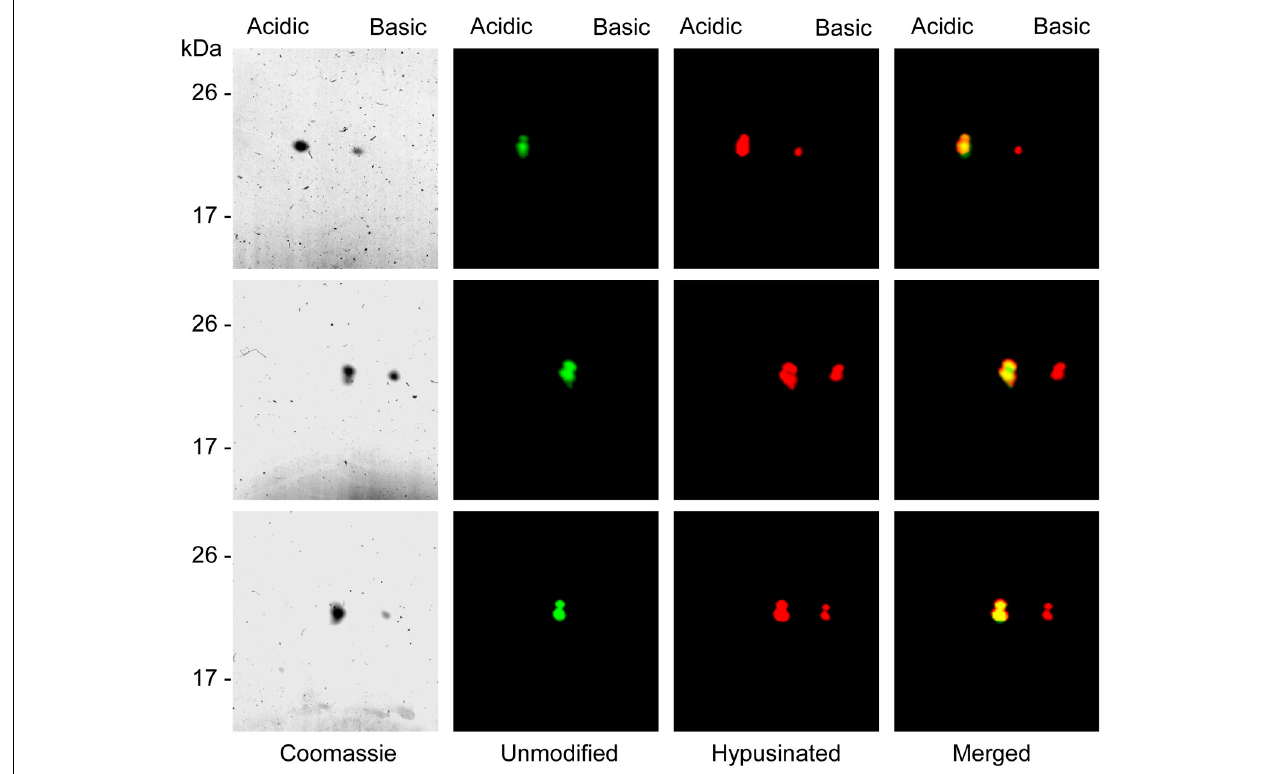
FIGURE 4 | Separation of unmodified and hypusine-modified eIF5A proteins by 2D-E. eIF5A unmodified proteins were labeled with Cy3 dye and partially hypusine-modified eIF5A proteins were labeled with Cy5 fluorescent dye, mixed and separated by 2D-E. After fluorescent scanning the panel with unmodified proteins (green) shows a unique spot, whereas the panel with